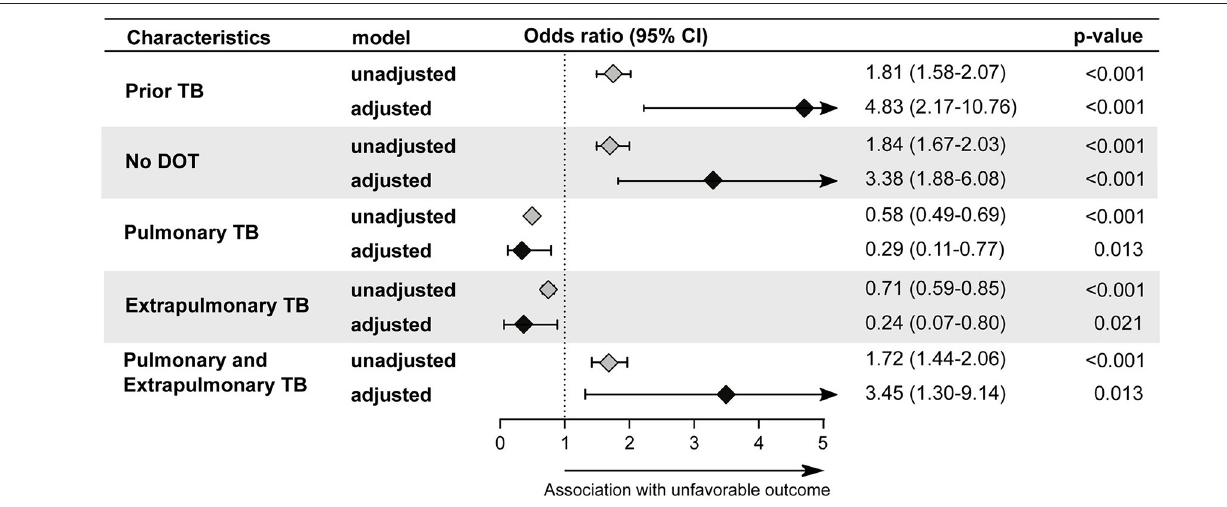
FIGURE 3 | Backward stepwise logistic regression model test independent associations between all the relevant clinical and epidemiological parameters and treatment outcome in children (0–9 years). The unfavorable outcome was used as reference to test associations. Only parameters which remained with p < 0.05 in in the adjusted model (95%CI: 95% confidence interval) were plotted. Adjustment was performed for each parameter: race (reference: indigenous); male (reference: female); illiterate(reference: literate); prior TB (reference: new case); no DOT (reference: Received DOT).Pulmonary TB (reference: Pulmonary and Extrapulmonary TB); Extrapulmonary TB (Reference: Pulmonary and Extrapulmonary TB); Pulmonary and Extrapulmonary TB (reference: Pulmonary TB); HIV infection (reference: without HIV infection); Alcohol Consumption (reference: no alcohol consumption); Diabetes (reference: no diabetes); Illicit drug use (reference: no illicit drug use); Smoking habit (reference: no smoking). Cancer (reference: no condition); COPD (reference: no condition); Kidney disease (reference: no condition); Hypertension (reference: no condition); Other comorbidities (reference: no condition); Abnormal chest X-ray (reference: normal chest X-ray). TB, tuberculosis; DOT, directly observed